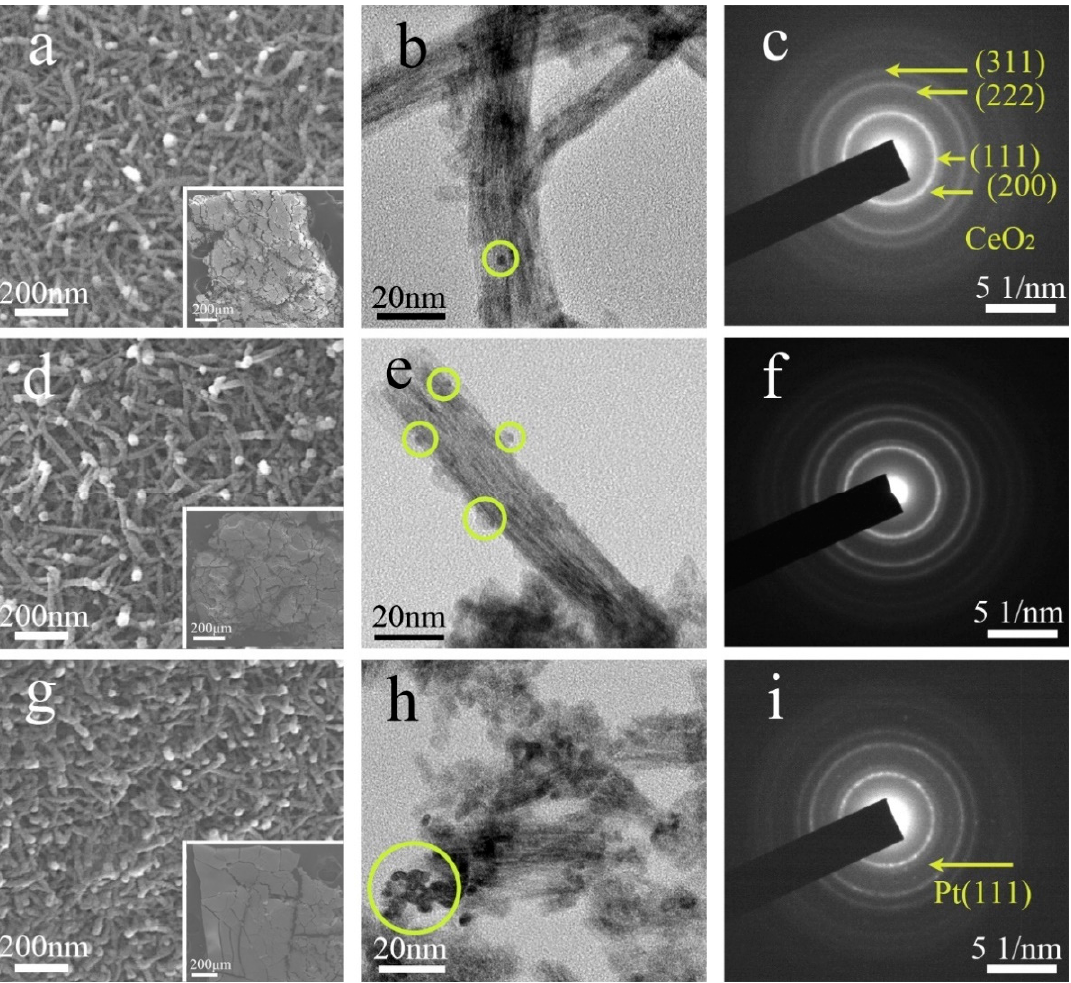
Figure 2. SEM, TEM and selected area electron diffraction (SAED) images of ( a , b , c ) dealloyed Al 91.9 Ce 8 Pt 0.1 , ( d , e , f ) Al 91.7 Ce 8 Pt 0.3 and ( g , h , i ) Al 91.5 Ce 8 Pt 0.5 ribbons calcined at 300 °C. The insert images of ( a , d , g ) are the low magnification SEM images of the samples.